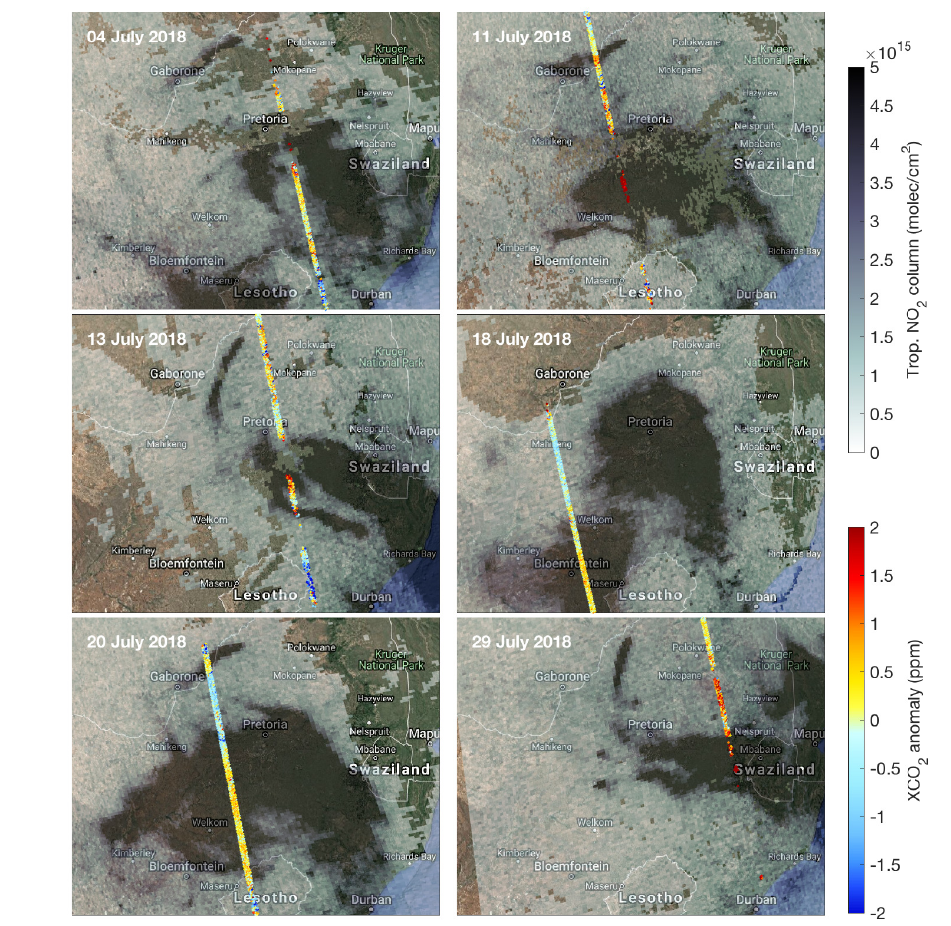
Figure 10. TROPOMI NO 2 tropospheric columns and local OCO-2 XCO 2 anomalies for six days in July 2018. Positive OCO-2 XCO 2 anomalies (yellow-red colors) are visible over the plumes with the largest NO 2 enhancements (dark gray areas). Data are overlapped to the Google map background.